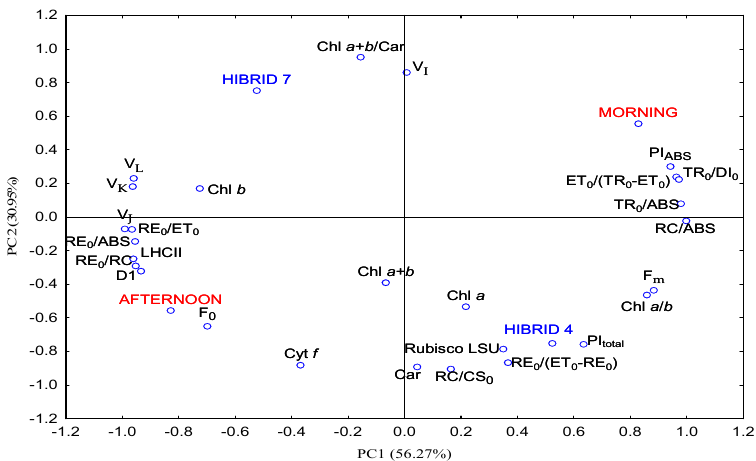
Figure 4. Biplot of principal component analysis of chlorophyll a fluorescence, photosynthetic pig- ment contents, and photosynthetic proteins in hybrids 4 and 7 (blue colour) under the morning and afternoon conditions (red colour). JIP parameters: minimum fluorescence intensity (F 0 ); maximum fluorescence intensity (F m ); relative variable fluorescence at 150 μ s (V L step); relative variable fluo- rescence at 300 μ s (V K step); relative variable fluorescence at 3 ms (V J step); relative variable fluorescence at 30 ms (V I step); maximum quantum yield of PSII (TR 0 /ABS); density of active PSII reaction centers (RCs) per cross section (RC/CS 0 ); density of RC on chlorophyll a basis (RC/ABS); flux ratio trapping per dissipation (TR 0 /DI 0 ); electron transport further than primary acceptor Q A (ET 0 /(TR 0 -ET 0 )); performance index (PI ABS ); quantum yield for reduction in the end electron acceptors at the PSI acceptor side (RE 0 /ABS); probability that an electron from the electron transport chain is transferred to reduce end electron acceptors at the PSI acceptor side (RE 0 /ET 0 ); electron-flux-reducing end electron acceptors at the PSI acceptor side per RC (RE 0 /RC); electron transport from PQH 2 to final PSI acceptors (RE 0 /(ET 0 -RE 0 )); and performance index for energy conservation from exciton to the reduction in the PSI end acceptors (PI total ). Photosynthetic pigment content: chlorophyll a (Chl a ); chlorophyll b (Chl b ); total chlorophyll a + b (Chl a + b ); total carotenoids (Car); ratio of chlorophyll a and b (Chl a / b ); and ratio of total chlorophyll content and carotenoids (Chl a + b /Car). The relative accumulation of photosynthetic proteins: light-harvesting complex of photosystem II (LHCII); D1; cytochrome f (cyt f ); and Rubisco large subunit (Rubisco LSU).